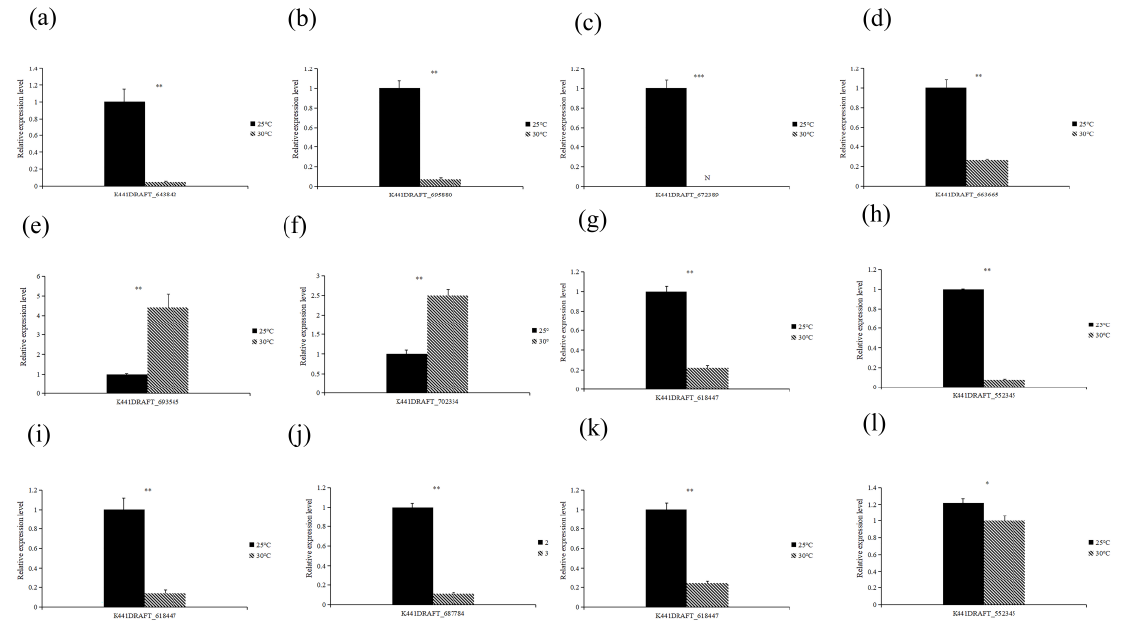
Figure 9. RT-qPCR analysis of the expression level of nine candidate genes in different samples. ( a , b ) two key genes verified by ACg07, ( c , d ) two key genes verified by ChCg28, ( e , f ) two key genes verified by ChCg100, ( g , h ) two key genes verified by ChCg01, ( I , j ) two key genes verified by JaCg144, ( k , l ) two key genes verified by JaCg202. The Cenococcum geophilum 18S gene was used as an internal control and gene expression profiles were evaluated using the 2 −ΔΔCt method. Three bi- ological replicates and three technical replicates for each sample were performed, and the bars represented the SD of the average mean. Black bars represent relative gene expression under con- trol (25 °C), and the black and white bars represent relative gene expression under treatment (30 °C). The statistically significant difference between the control and high temperature treatment groups (Student’s t -test): * p < 0.05; ** p < 0.01; *** p < 0.0001. N represents the gene that is not ex- pressed under 30 °C treatment.